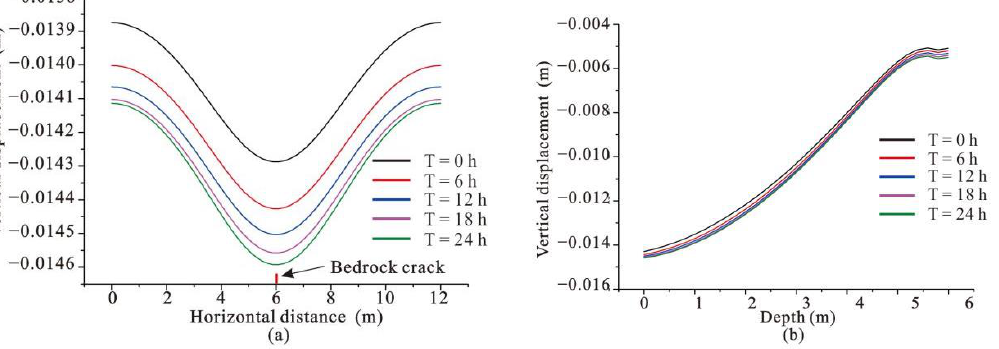
Figure 15. Vertical displacement curves. ( a ) Variation curve of vertical displacement of surface soil with time; ( b ) variation curve of soil vertical displacement with time at different depths above con- cealed